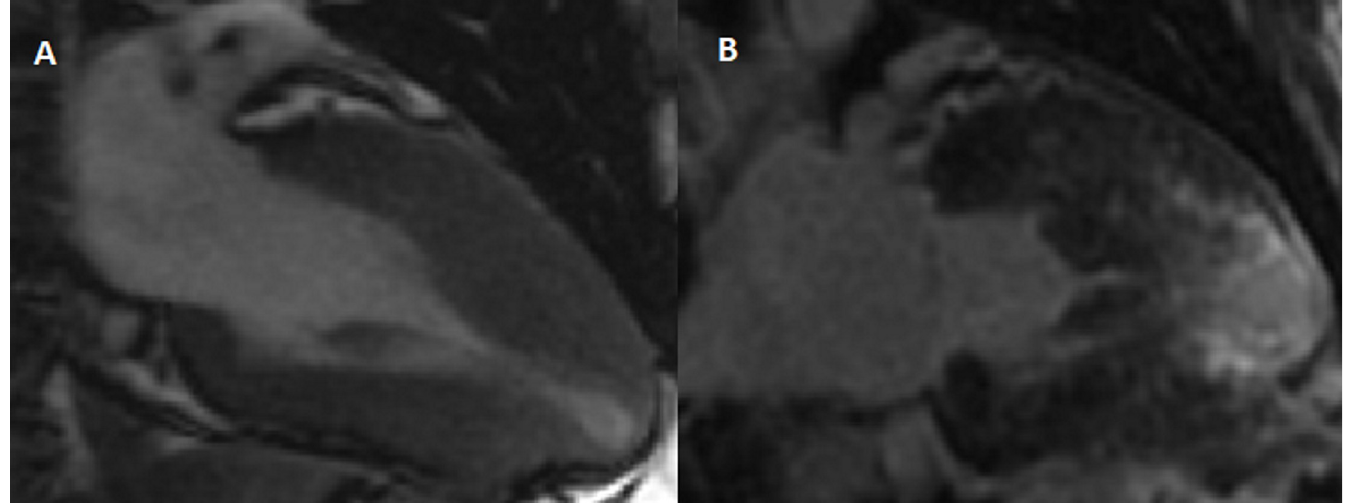
Fig 1. Cardiac magnetic resonance characterization of a patient with a MYH7 variant. Panel A. Cine images at end systole showing apical hypertrophy with apical aneurysm. Panel B. Delayed enhancement images showing extensive LGE in the distal myocardial segments including the